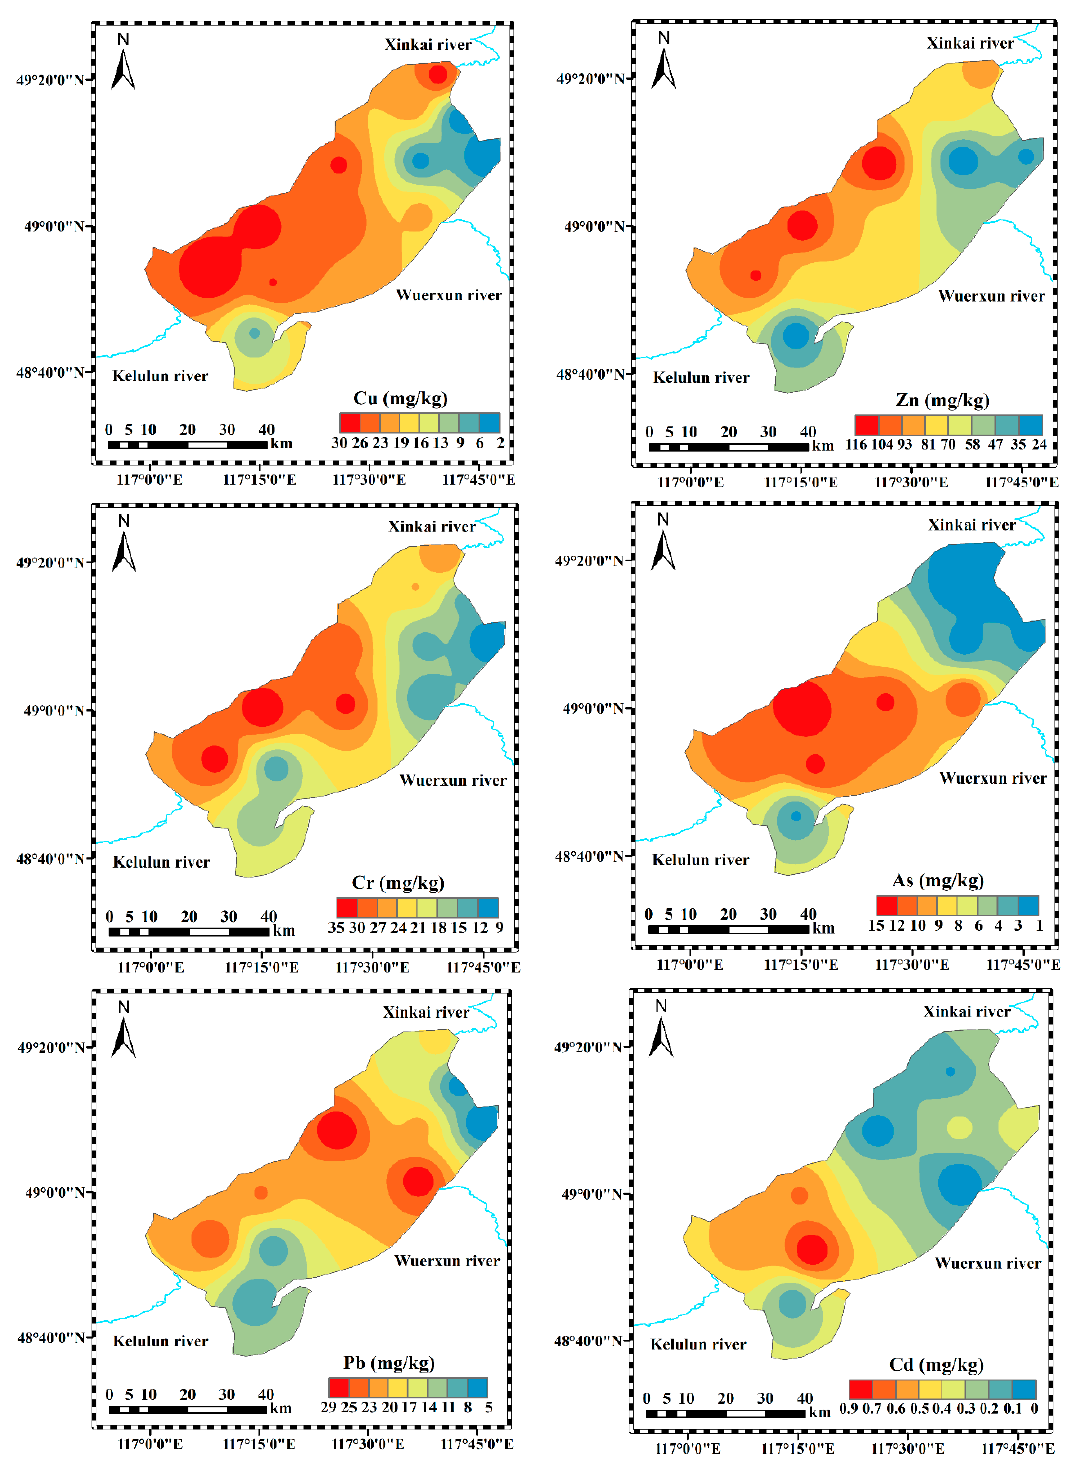
Figure 2. Spatial distribution patterns of heavy metals in the surface sediments of the Hulun Lake.